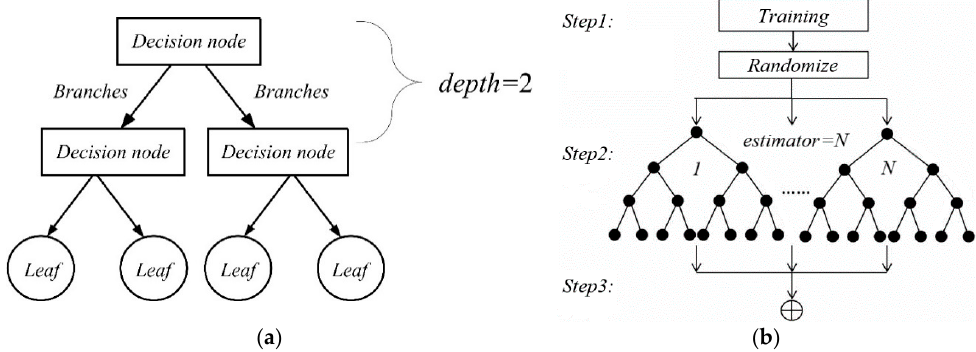
Figure 2. Demonstration of ( a ) decision tree structure and ( b ) RF algorithm.